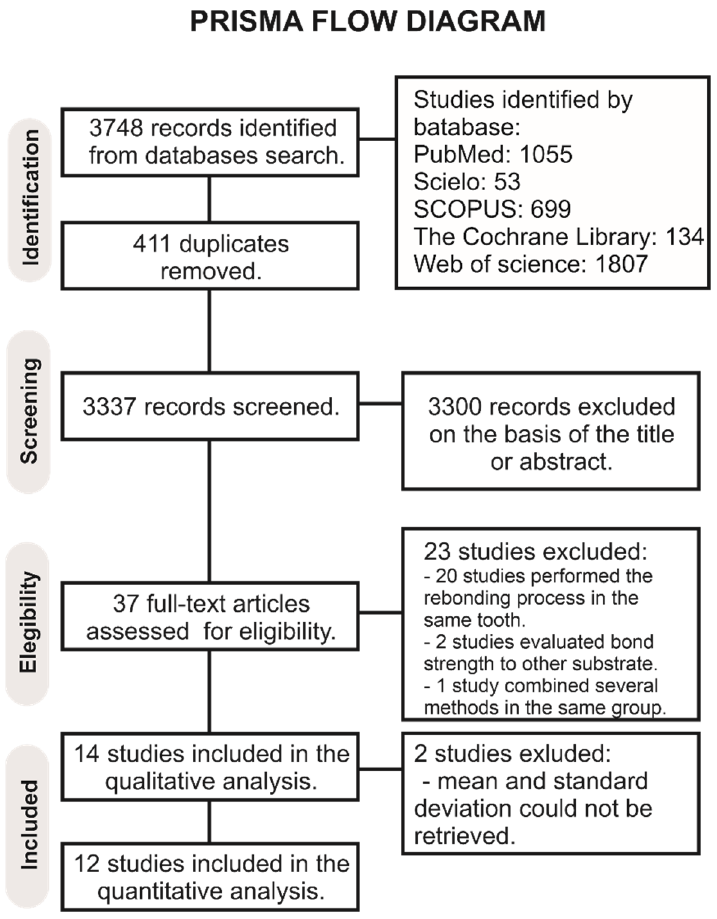
Figure 1. Prisma flow diagram of the study.